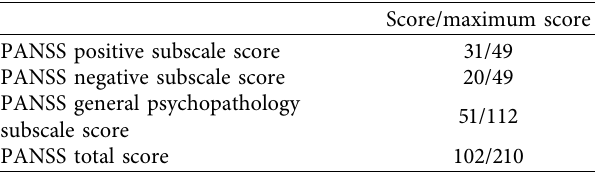
Table 1: Patient’s PANSS subscale